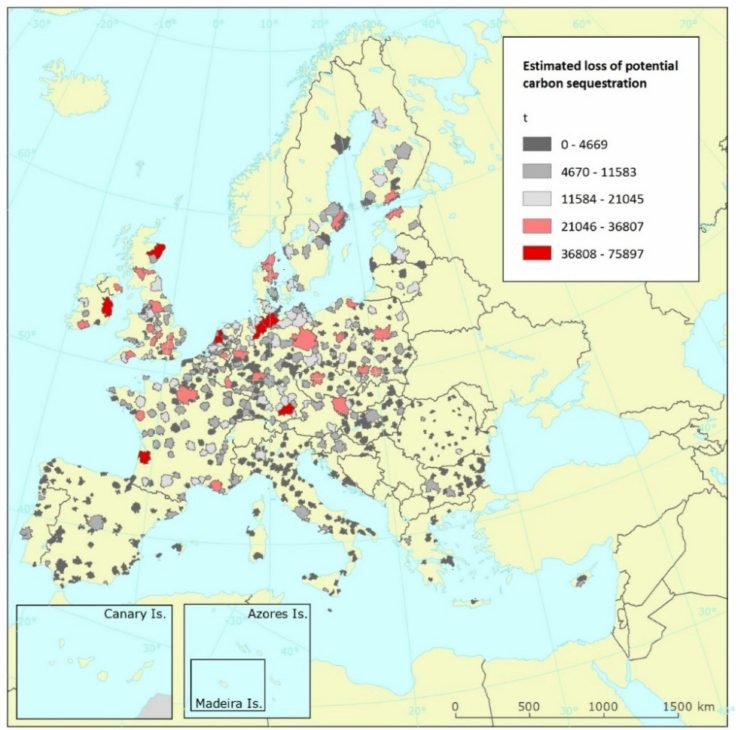
Figure 6. Estimated loss of soil carbon sequestration potential in Functional Urban Areas as a result of sealing during